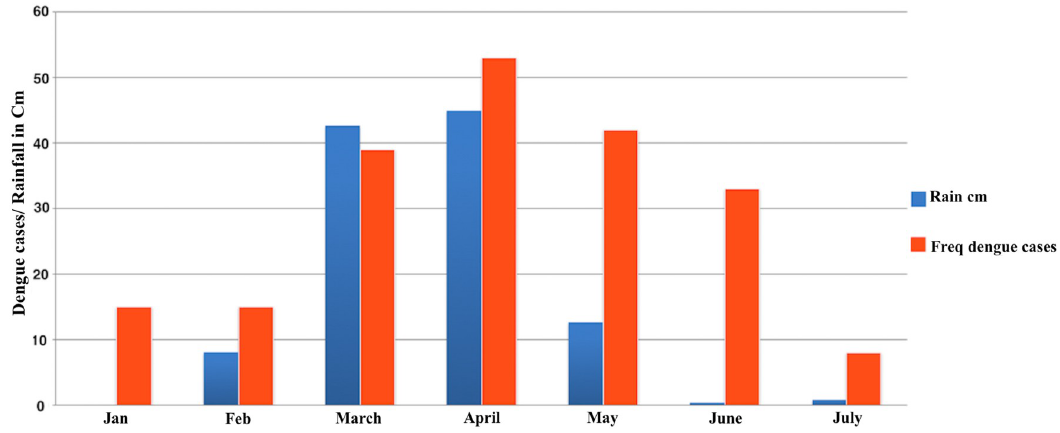
Fig 4. The relationship between rainfall and dengue outbreak